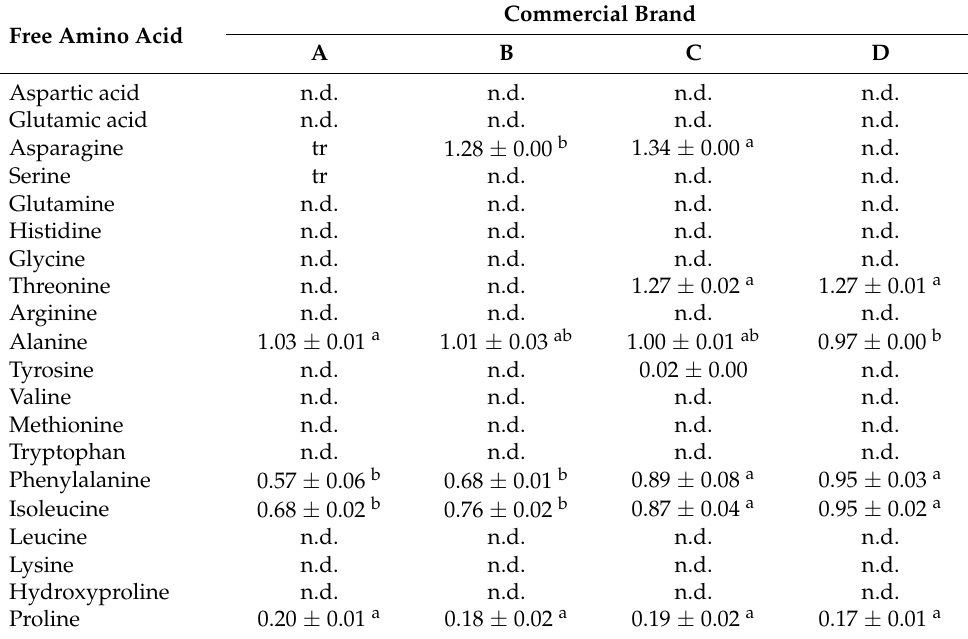
Table 5. Free amino acids (ng/mL) of rosemary infusions from different commercial brands, detected and quantified by RP-HPLC-FLD.